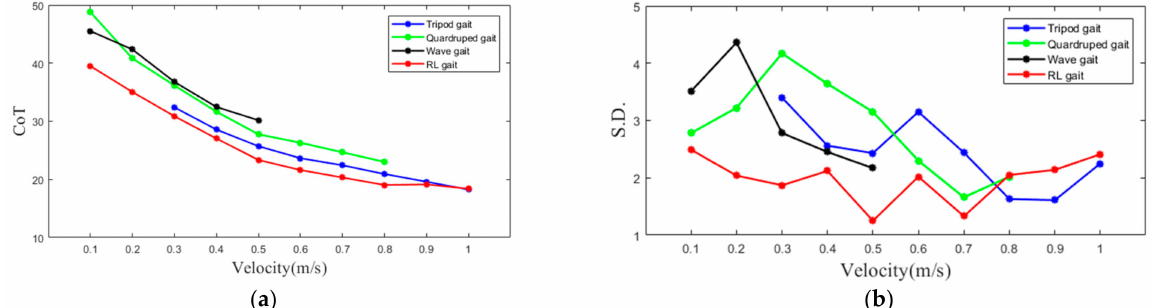
Figure 11. The mean CoT ( a ) and standard deviation ( b ) of the hexapod robot in four different gaits. Considering structural features and motion stabilization, a hexapod animal would not use a wave gait for fast walking and a tripod gait for slow walking.